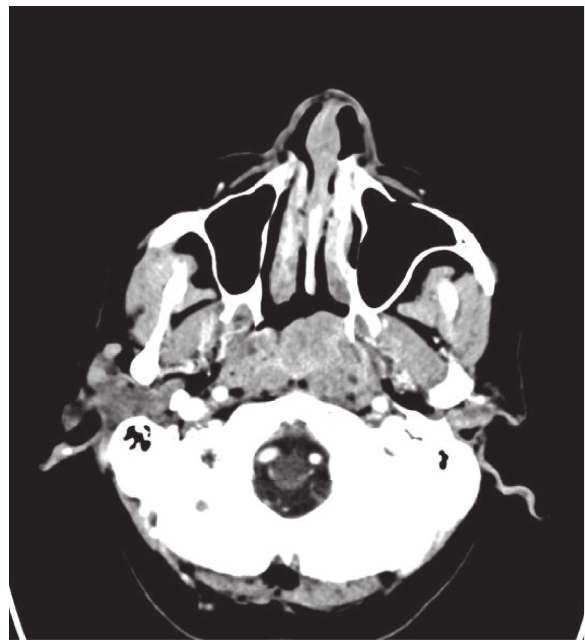
Figure 3: Axial CT imaging of the head showing the nasopha- ryngeal